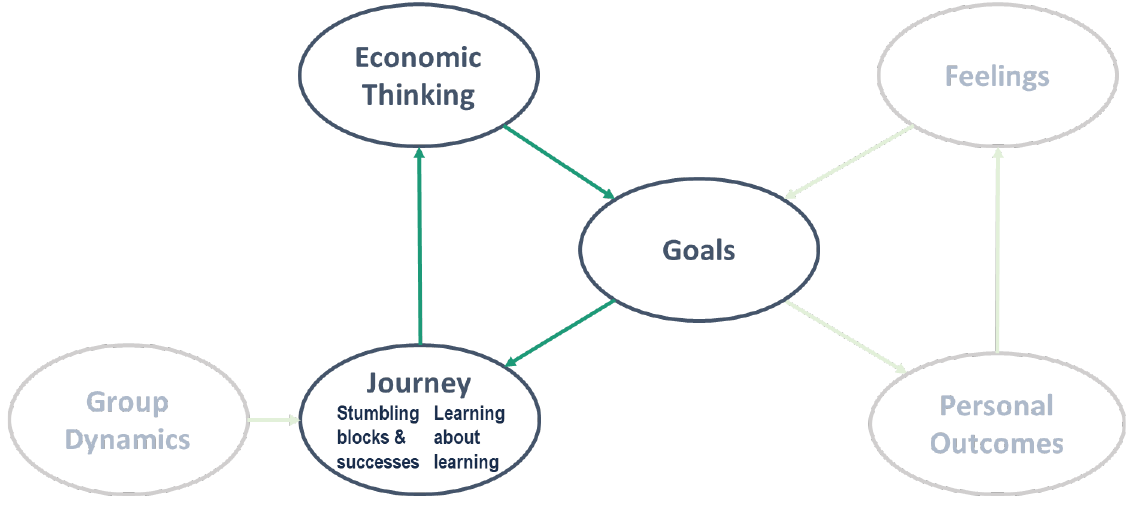
Figure 2 : Systems Influence Diagram: The ‘ H ead’ loop Goals, Personal Outcomes and Feelings were closely tied in a second potentially self- reinforcing sub-system embodying the affective, volitional, and identity-relevant aspects of individual learning. We called th is the ‘Heart’ loop.